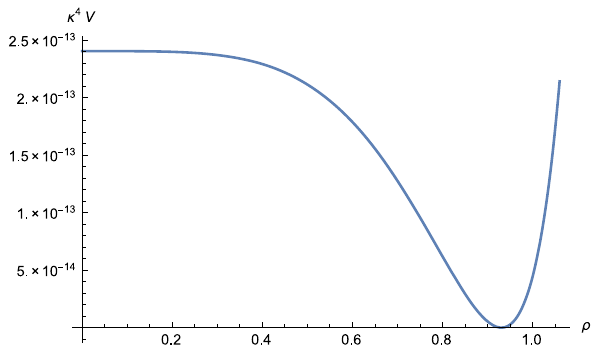
Fig. 3 AplotofthescalarpotentialgivenbyEq.(43)fortheparameters in Eq.